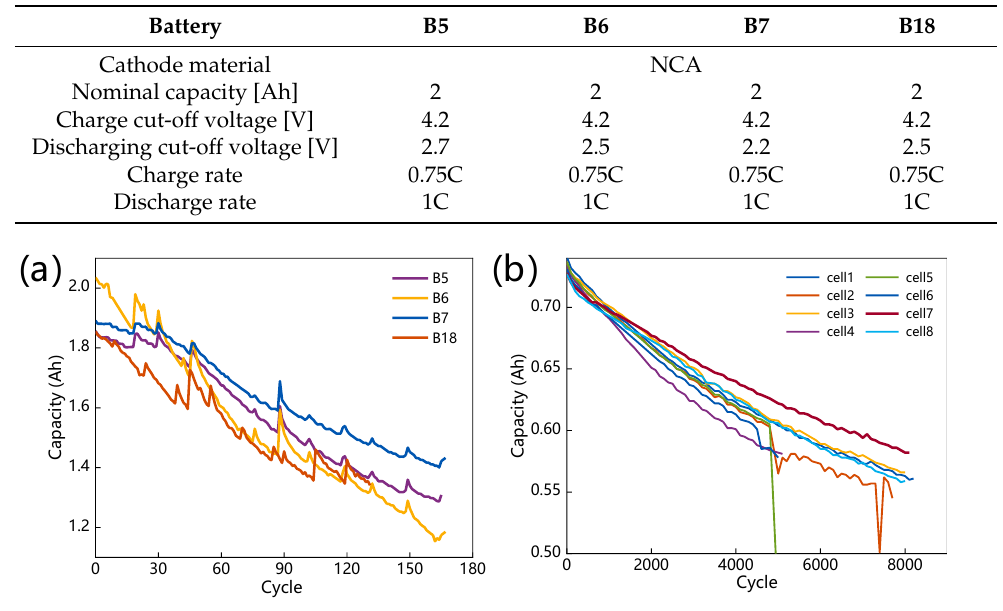
Figure 1. Capacity data of LIBs: ( a ) NASA; ( b ) Oxford.